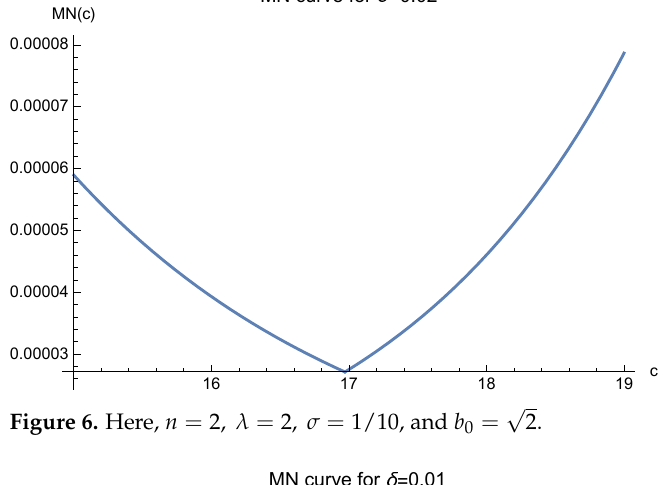
Figure 6. Here, n = 2, λ = 2, σ = 1/10, and b 0 =